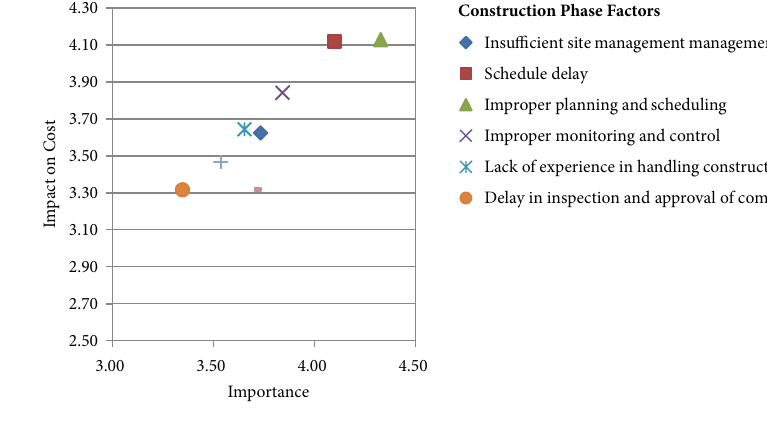
Figure 3. Risk matrix chart for cost overruns related to Construction Phase (Impact on Cost vs. Importance)